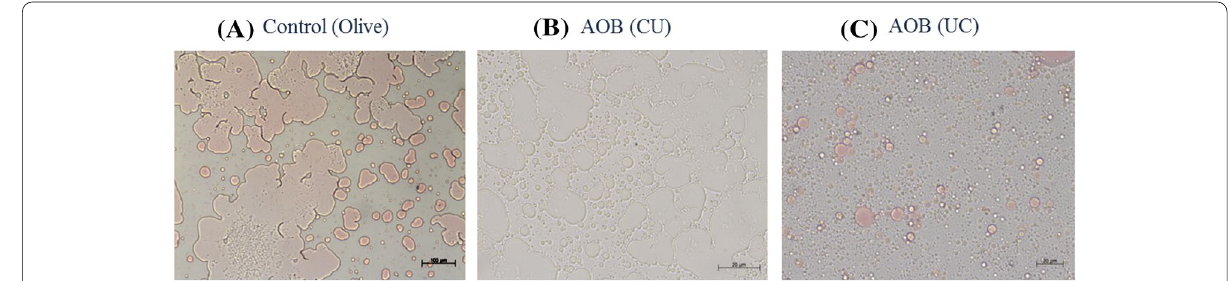
Fig. 2 Light microscopy of artificial oil bodies constituted with and without chimaera proteins. A Represents sonicated olive oil with no chimaera protein, while B and C show the sonicated olive oil in the presence of CU and UC chimaera, respectively. The bar represents 100 μm for control and 20 μm for two